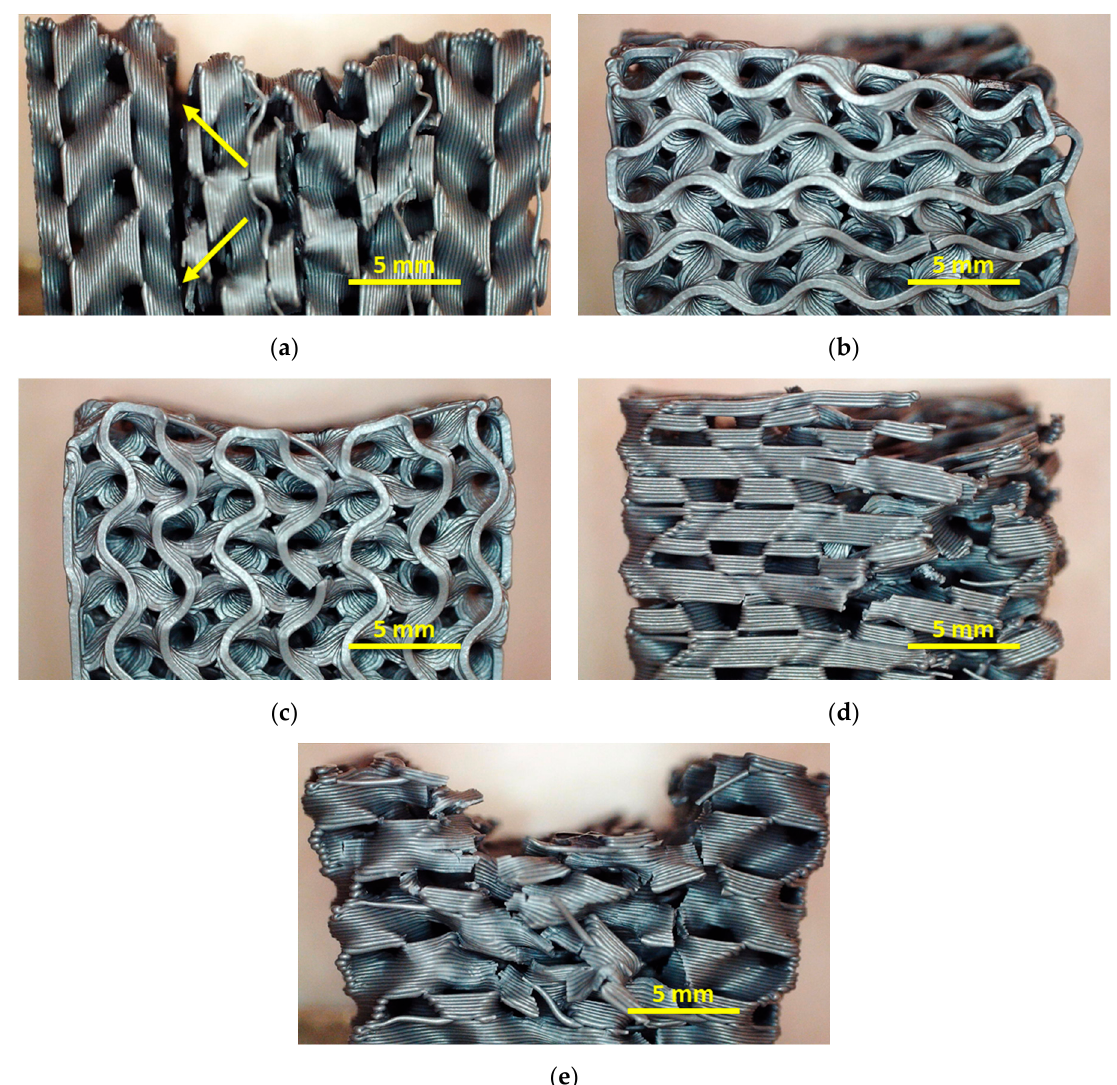
Figure 9. Microscopic images of samples after 10 pressure and recovery cycles: ( a ) front horizontal with full break (between arrows); ( b ) front diagonal, image taken from top; ( c ) front vertical; ( d ) top diagonal; ( e ) top parallel.